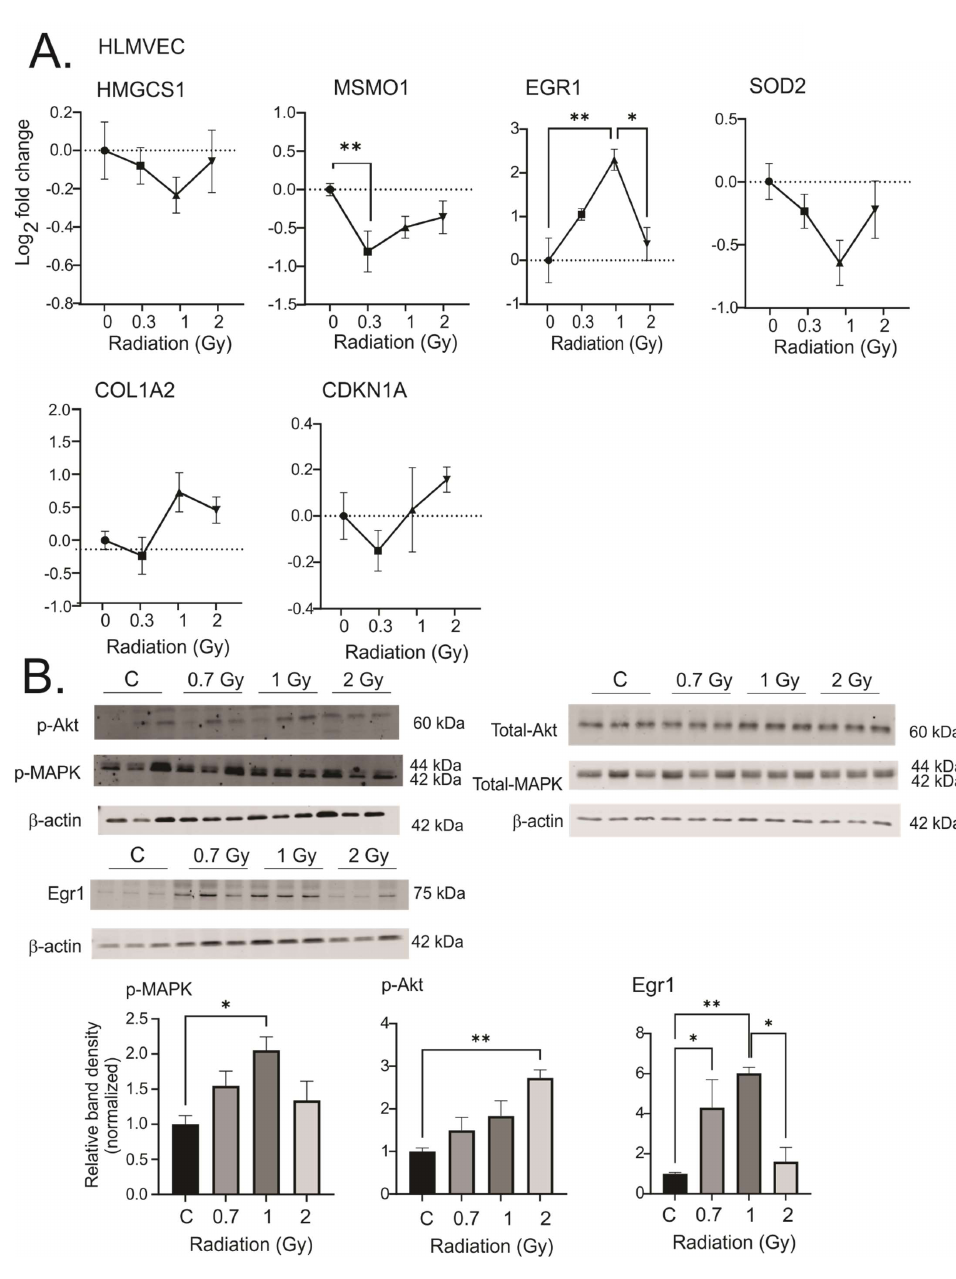
Figure 10. Response of human lung microvascular endothelial cells (HLMVECs) to chronic low dose-rate irradiation. HLMVECs were grown to 50% confluence and exposed to 60 Co irradiation at 0.64 cGy/h for 1 Gy (1 week) or 2 Gy (2 weeks). Control cells were cultured under identical conditions. Irradiated and control cells were lysed at the same time, and either frozen for protein analysis or placed in RNAlater. ( A ). qPCR gene regulations are represented on a log base 2 fold change scale, using N = 3 biological replicates with two technical repeats. Graphs show means ± SEM; * indicates p < 0.05 and ** indicates p < 0.01, respectively, compared with sham-irradiated control cells. ( B ). Western blots of phosphorylated and total MAPK and Akt, and Egr1. Western blots were performed on N = 3 biological repeats. Bar graphs show average band densities normalized to β -actin. Graphs show means ± SEM; * indicates p < 0.05 and ** indicates p < 0.01, respectively, compared with sham-irradiated control